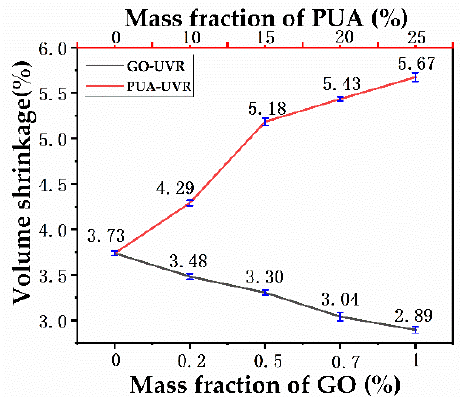
Figure 7. Volume shrinkage of free − radical/cationic hybrid, polyurethane acrylates modified, and graphene oxide modified photosensitive resins.